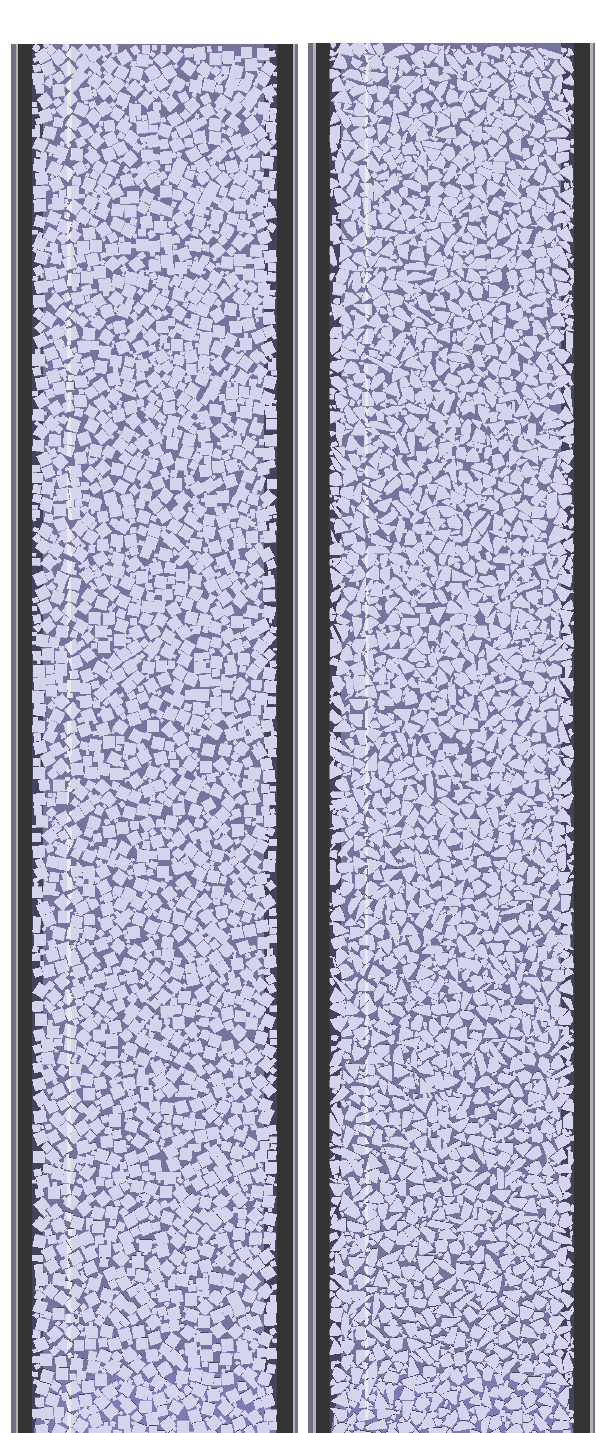
Algorithm 3 Polygon expansion procedure.